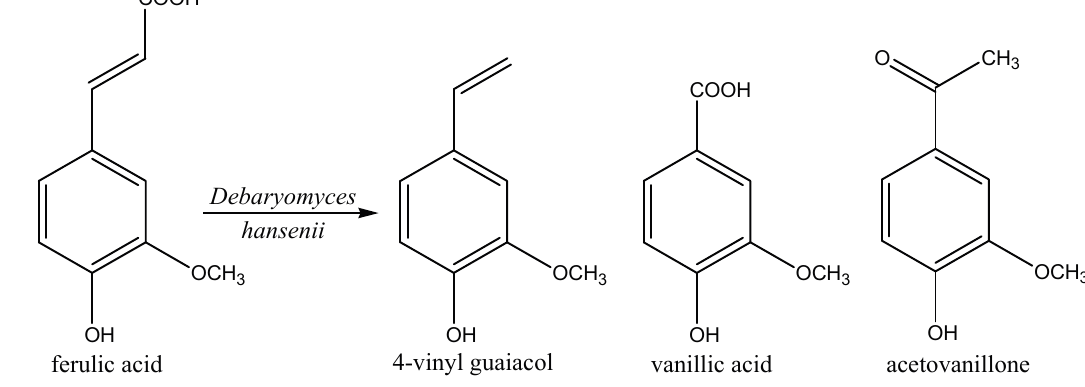
Figure 12. Biotransformation of ferulic acid into higher value added products by Debaryomyces hansenii